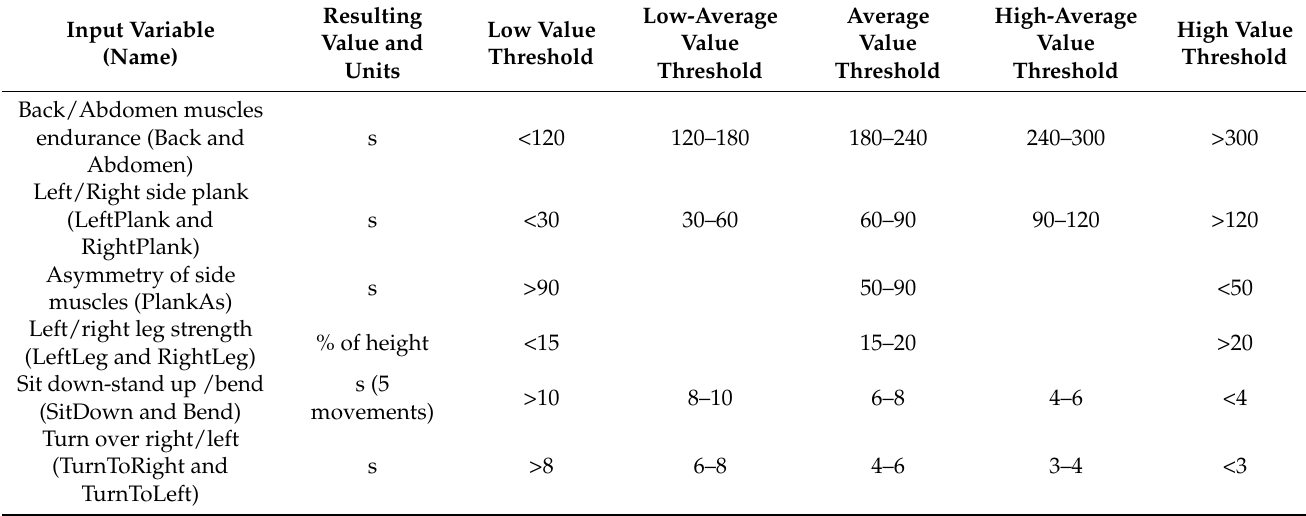
Table 4. Measured parameters and values for the muscular system evaluation in the proposed expert system.